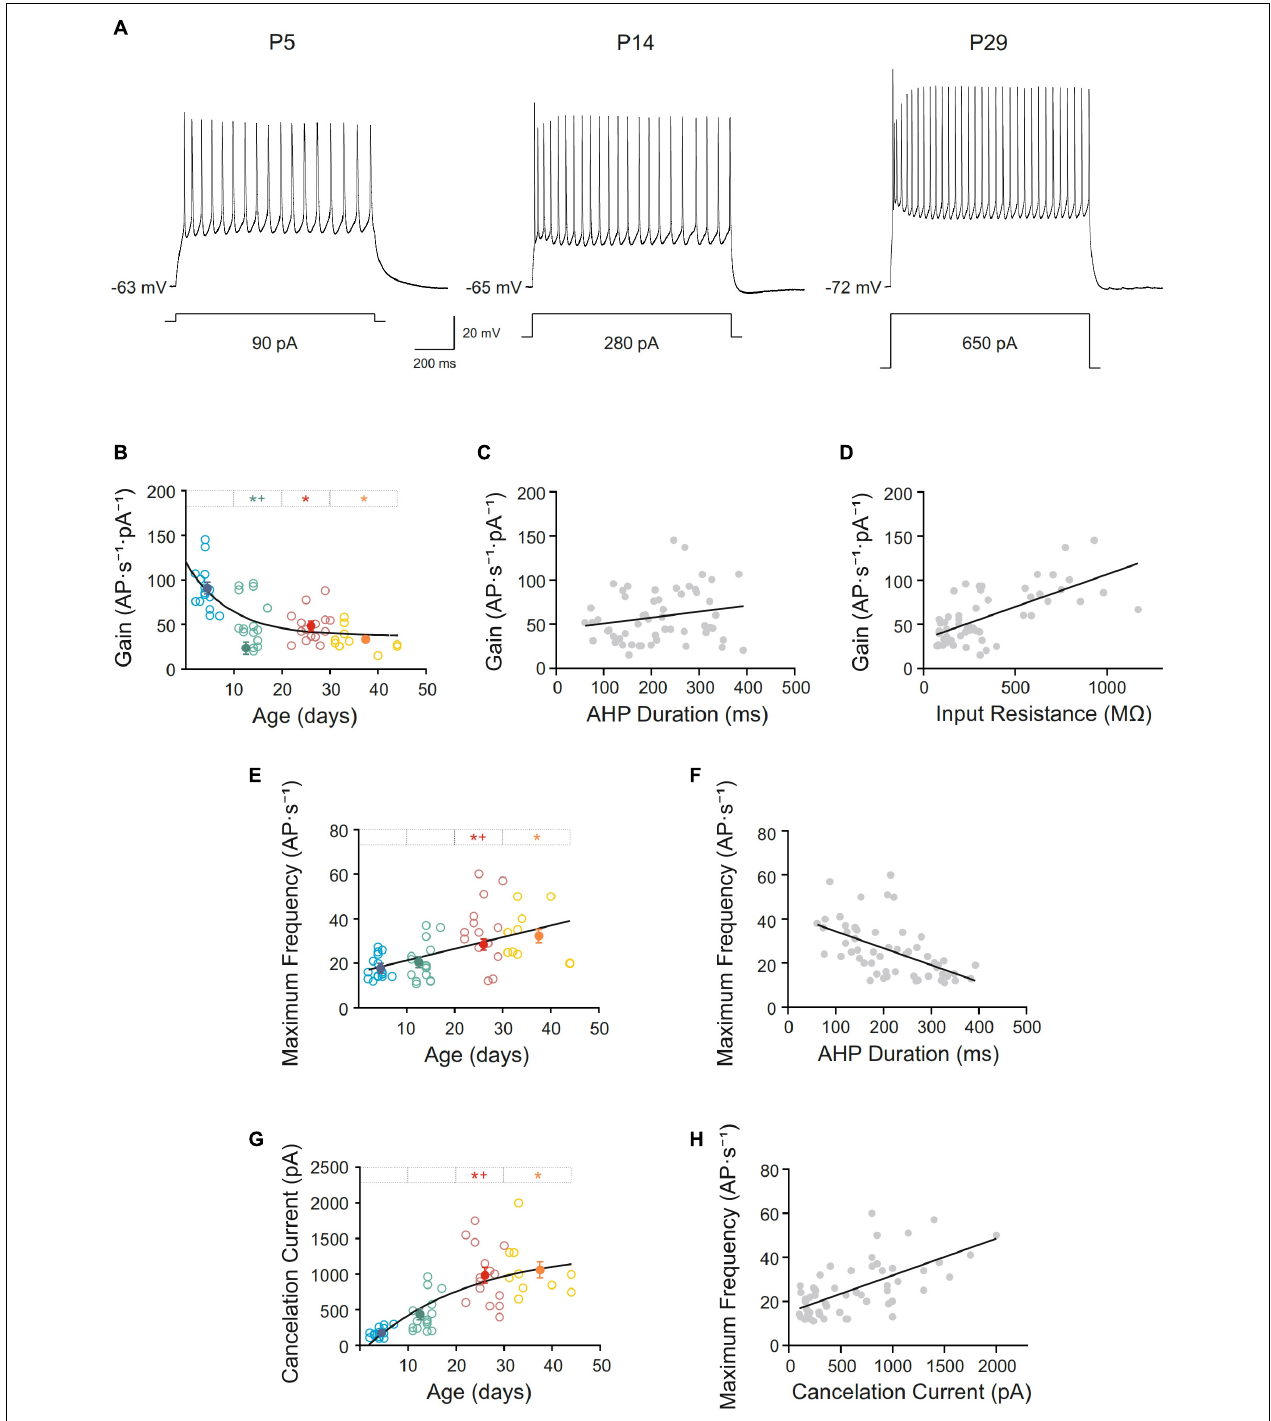
FIGURE 5 | Postnatal development of repetitive firing properties of motor cortex pyramidal neurons. (A) Membrane voltage responses to long-lasting current pulse (1s) in representative neurons of different ages. (B,E,G) Scatter plots showing the firing frequency gain (B) , maximum frequency (E), and cancelation current (G) as a function of postnatal age. Open symbols represent the raw data, while filled symbols are the means of the four different age groups and their standard errors. Each group is represented by a color (blue = newborn, n = 15; green = infantile, n = 15; red = young adult, n = 15; yellow = adult, n = 10). An asterisk indicates a significant difference from the newborn group; a cross indicates a difference between adjacent groups. The significance level was established as p ≤ 0.05. (C,D,F,H) Correlation between gain and the afterhyperpolarization phase (AHP) duration, r = 0.20, p = 0.14 (C) , gain and input resistance, r = 0.67, p < 0.0001 (D) and maximum frequency and AHP duration, r = –0.54, p < 0.0001, (F) and maximum frequency and cancelation current, r = 0.64, p < 0.001 (H) .